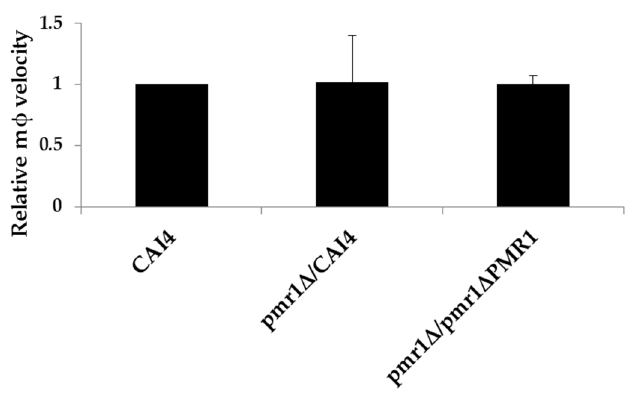
Figure 5. Quantitative analysis of macrophage migration within 48 h biofilms prepared from C. albicans strains CAI4, pmr1 Δ , and pmr1 Δ + PMR1 . The chart shows mean relative macrophage velocity + SD relative to macrophage velocity of J774.1 macrophages added in suspension to CAI4 (wild type biofilms). Migration data over a 30 min period are shown. No statistical significance of mean differences was determined using one-way analysis of variance (ANOVA) and Tukey Multiple Analysis Comparison Tests.